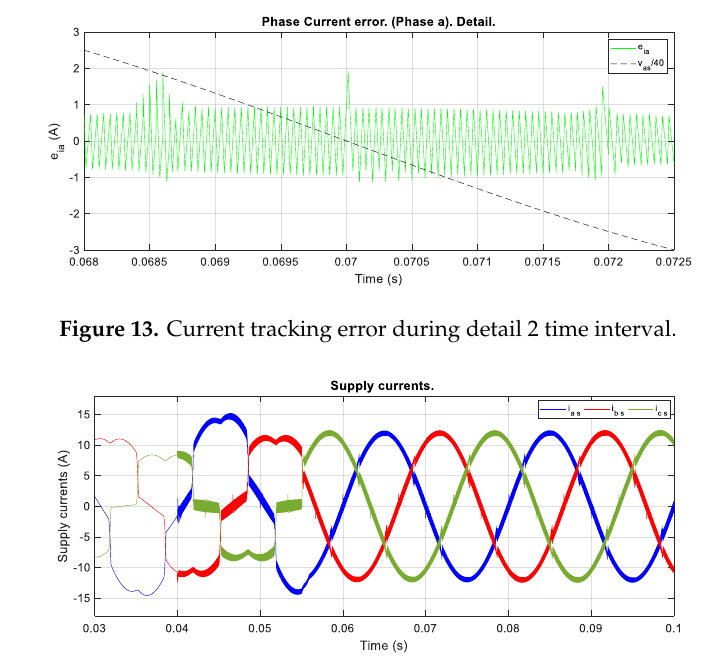
Figure 14. Supply currents before and during SAPF compensation.